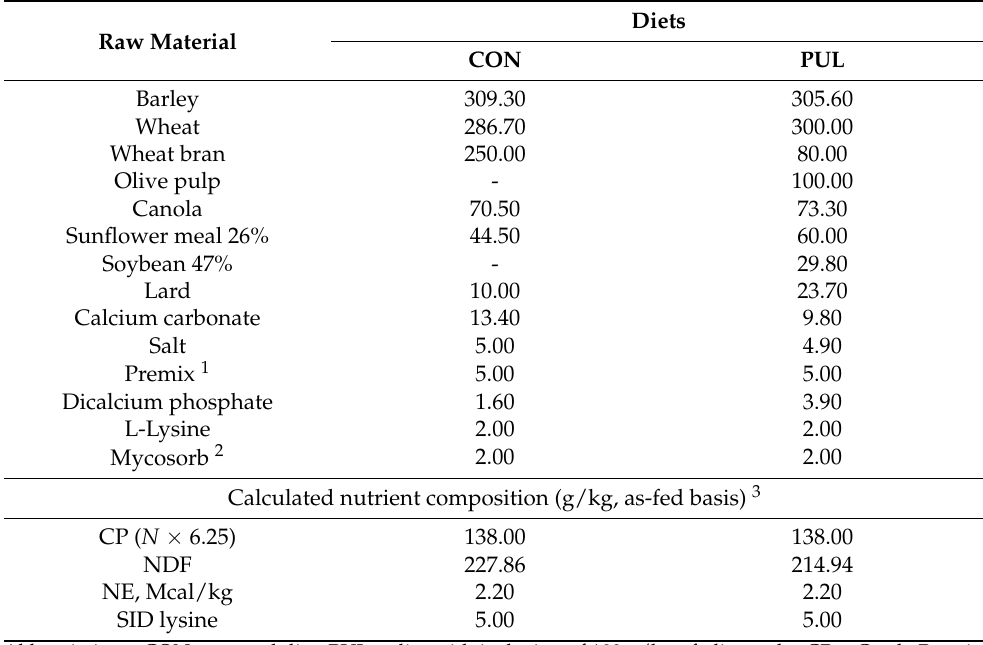
Table 1. Diet composition (g/kg) and nutrient levels estimates of diets (g/kg, as-fed basis) for Iberian gestating